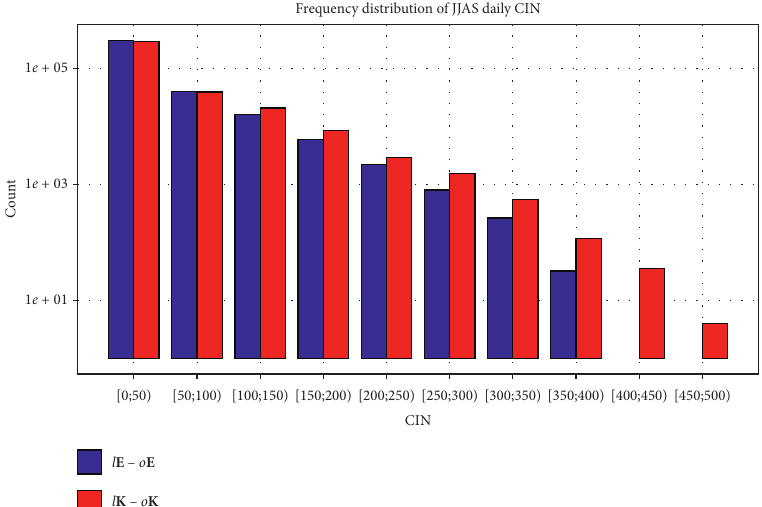
Figure 11: Frequency distribution of daily CIN (J/kg) during the 10-year JJAS period (1998–2007) from 56 stations over the Korean Peninsula derived from l E − o E and l K − o K simulations. The square bracket represents the CIN greater than or equal to the value, while the parentheses represent the CIN less than the value.